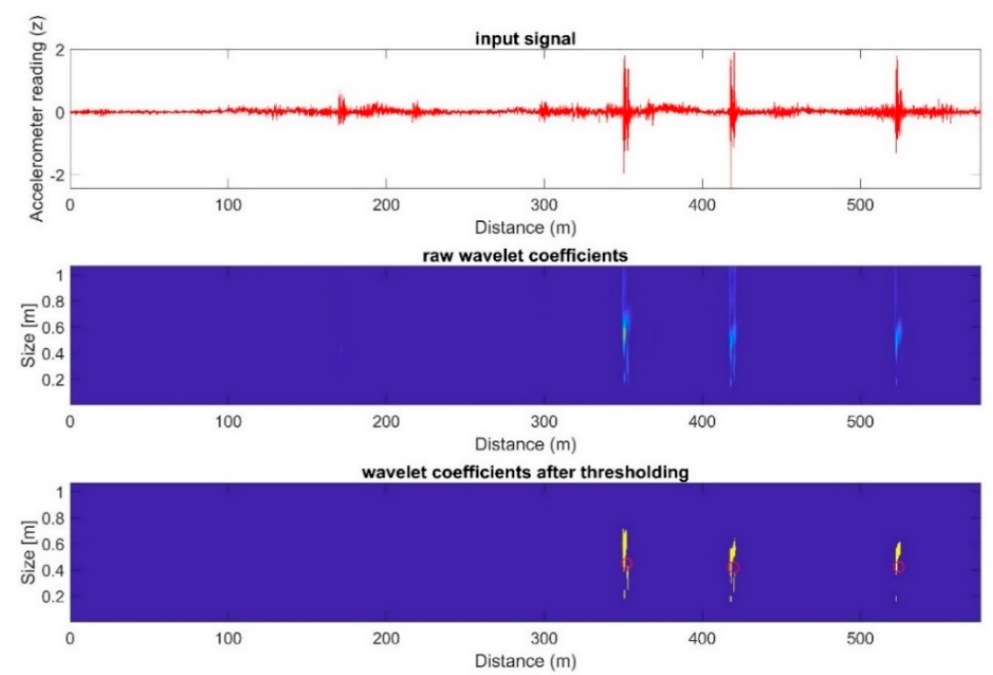
Figure 7. Wavelet analysis results.